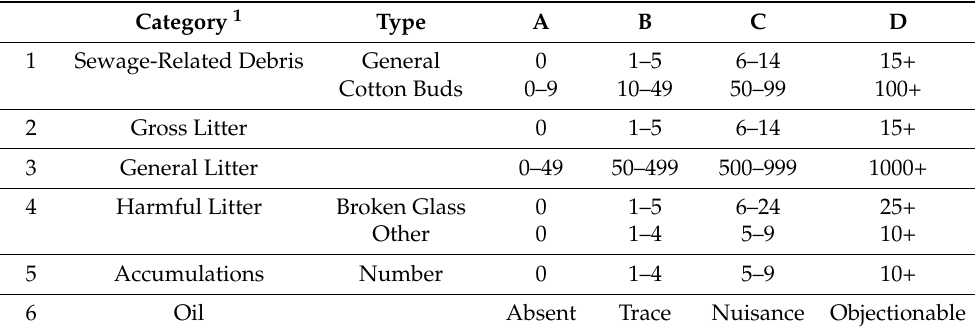
Table 2. Litter grade categories